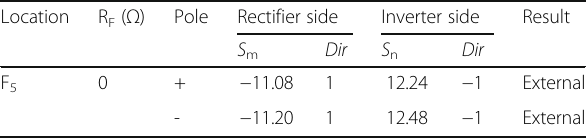
Table 5 Simulation results for a fault at F 5 Location